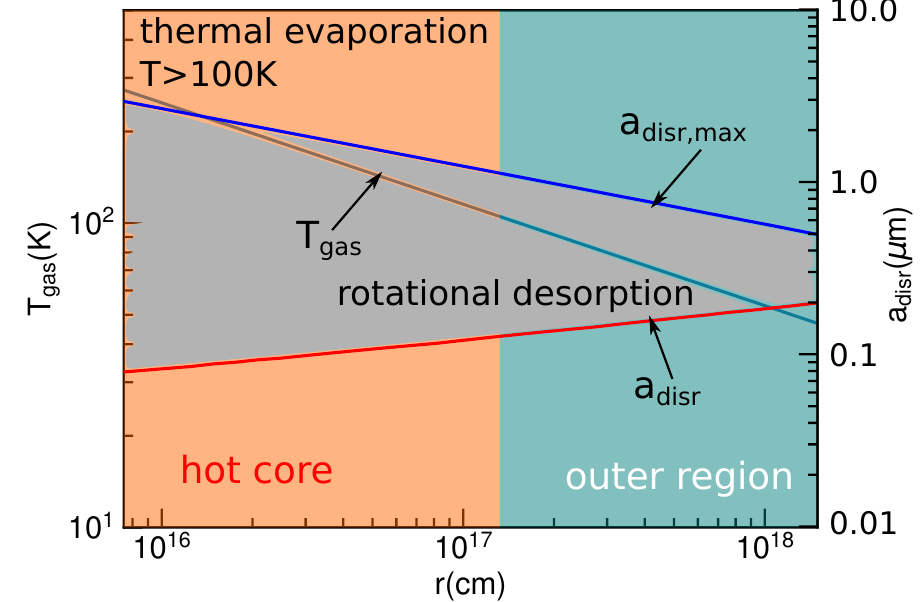
Figure 29. Gas temperature and grain disruption size vs. radius for an envelope around a high-mass protostar. Classical thermal sublimation is important only for the inner region (hot core), whereas rotational desorption is important for both hot core and outer